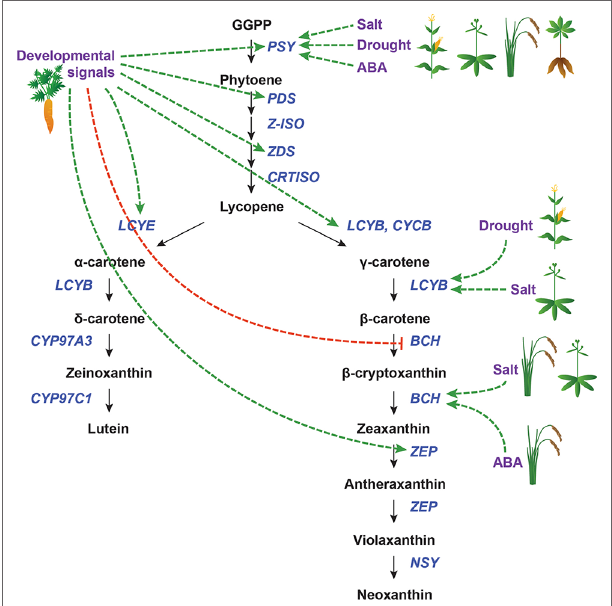
FIGURE 6 | Transcriptional regulation of CBP genes in roots. The regulation of CBP genes in root tissues. Icons indicate the species (carrot, cassava, maize, rice, and Arabidopsis ). Developmental and environmental cues are shown in purple. The carotenoid biosynthesis pathway is shown in black, with carotenoid biosynthesis genes indicated in dark blue. Carotenoid regulators discussed in the paper are shown in light blue. Green arrows indicate positive regulation, while blunt red arrows indicate negative regulation. Dotted lines show indirect/unknown